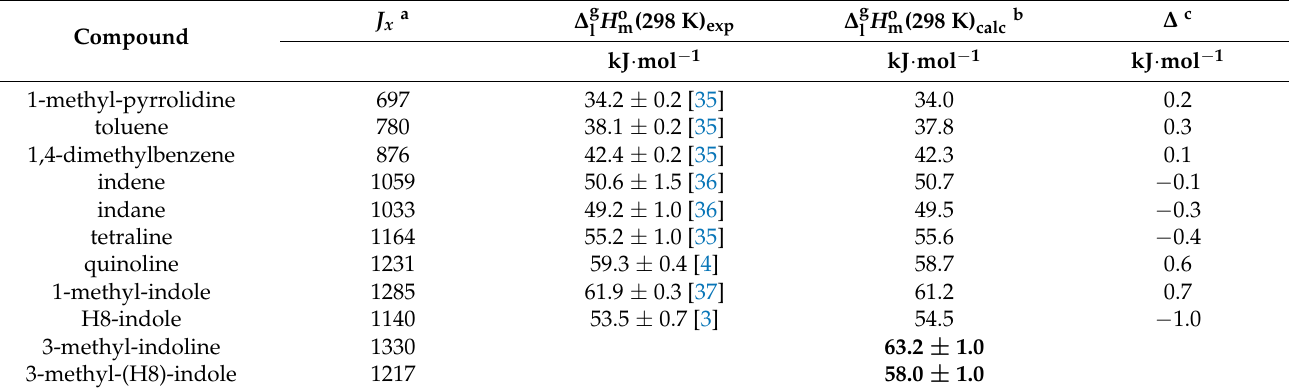
Table 6. Correlation of the vaporization enthalpies, ∆ g hydrocarbons with their Kovats indices ( J x